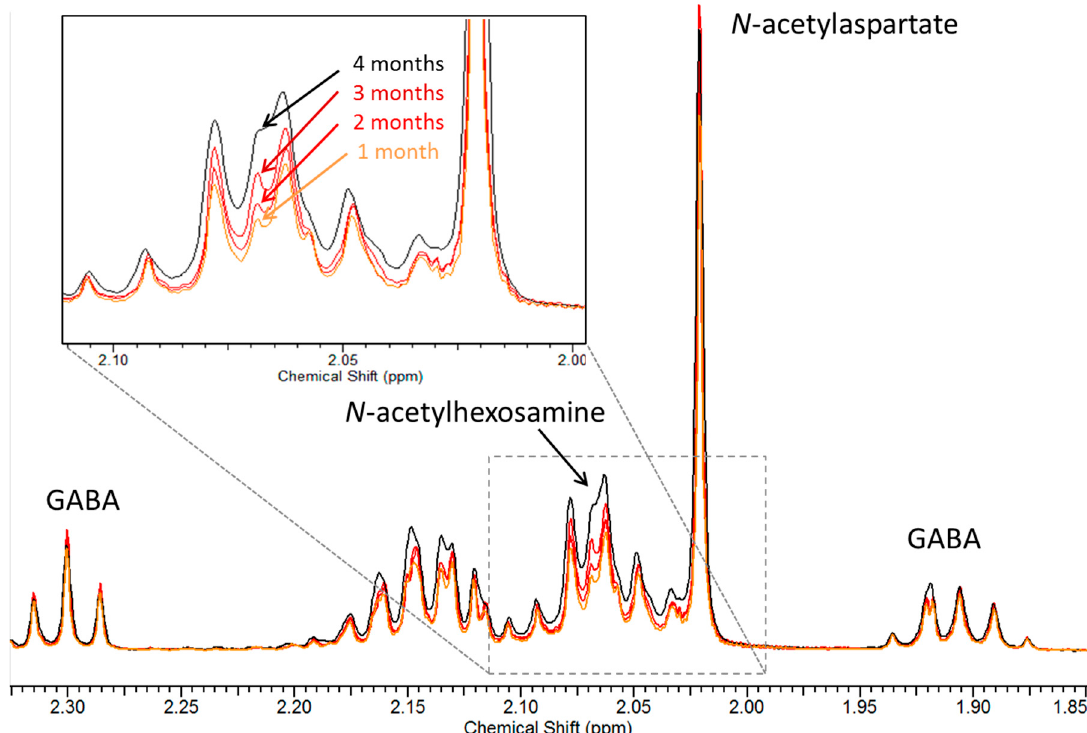
Figure 2. Expanded region (1.85–2.35 ppm) from the 1 H-NMR spectra of cerebrum tissue from one, two, three and four- month-old Hexb − / − mice. The resonance corresponding to N -acetylhexosamine, at 2.07 ppm, increased with time (insert). Other major resonances present in this region are as labelled. GABA: γ -aminobutyric acid.